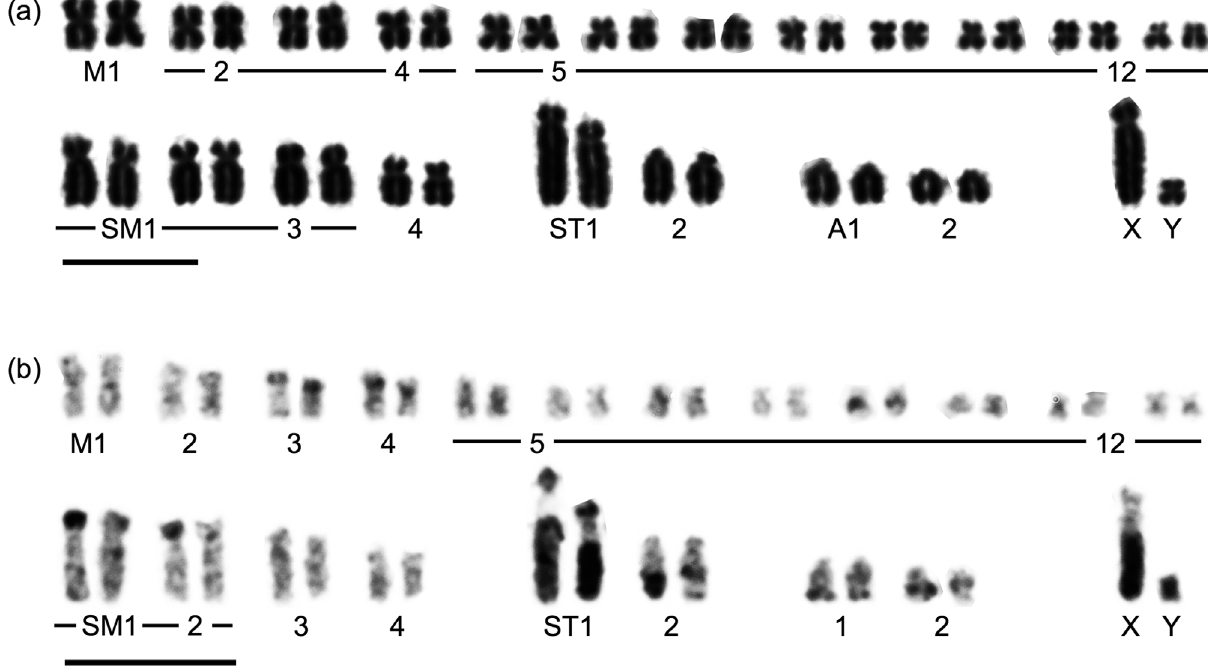
Figure 2 - Conventional (a) and C-banding karyotypes (b) of Mesoplodon stejnegeri . Bar = 10 (cid:2)